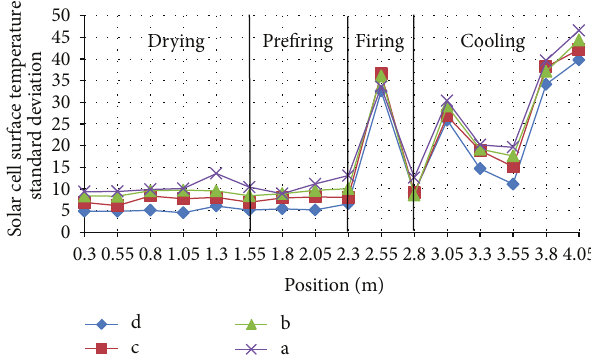
Figure 8: Temperature curves for the faces of the solar cells.